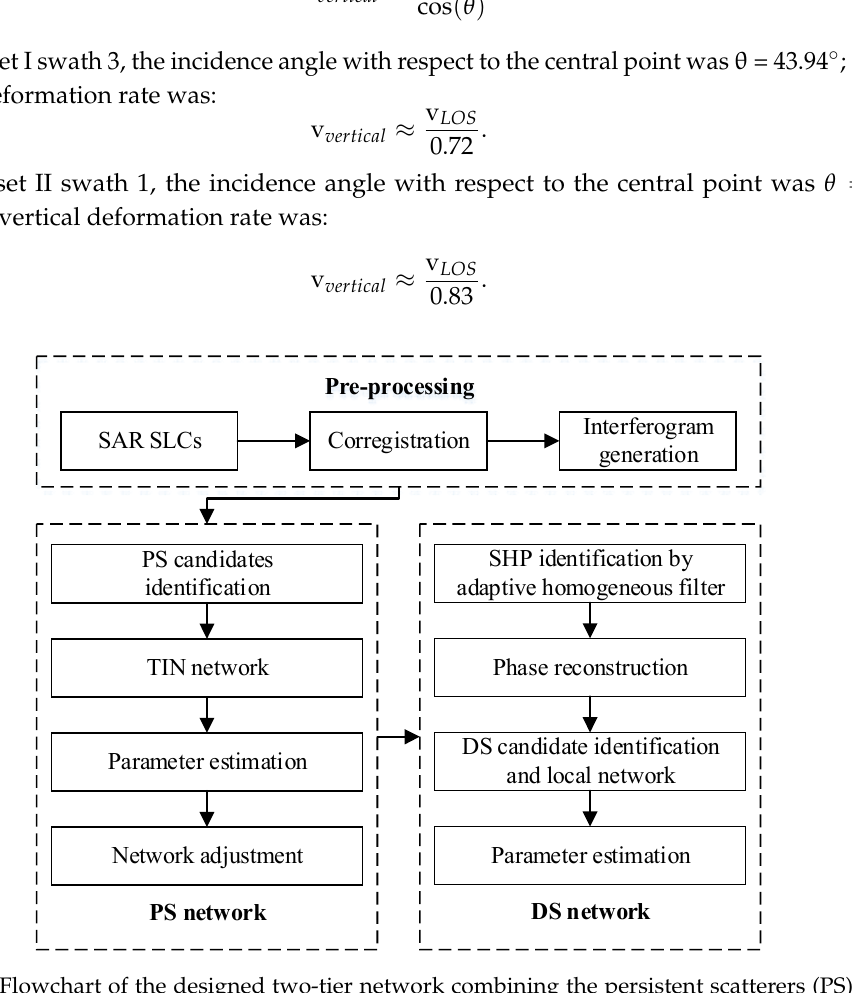
Figure 4. Flowchart of the designed two-tier network combining the persistent scatterers (PS) and distributed scatterers (DS) approaches.